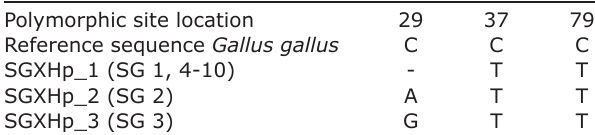
Table-4: Molecular definition of four Cyt b haplotypes from Aravali chicken population.